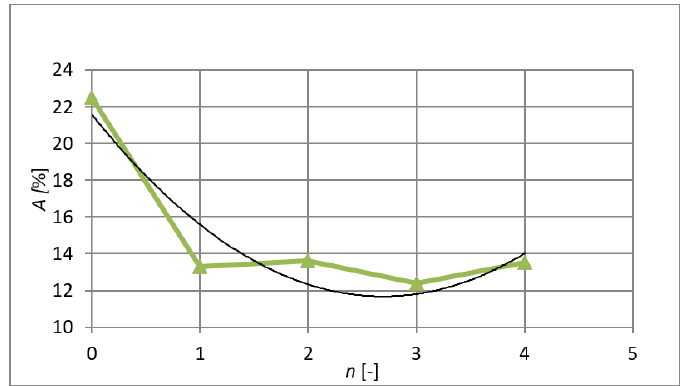
Figure 13. The course of ductility after individual extrusions.